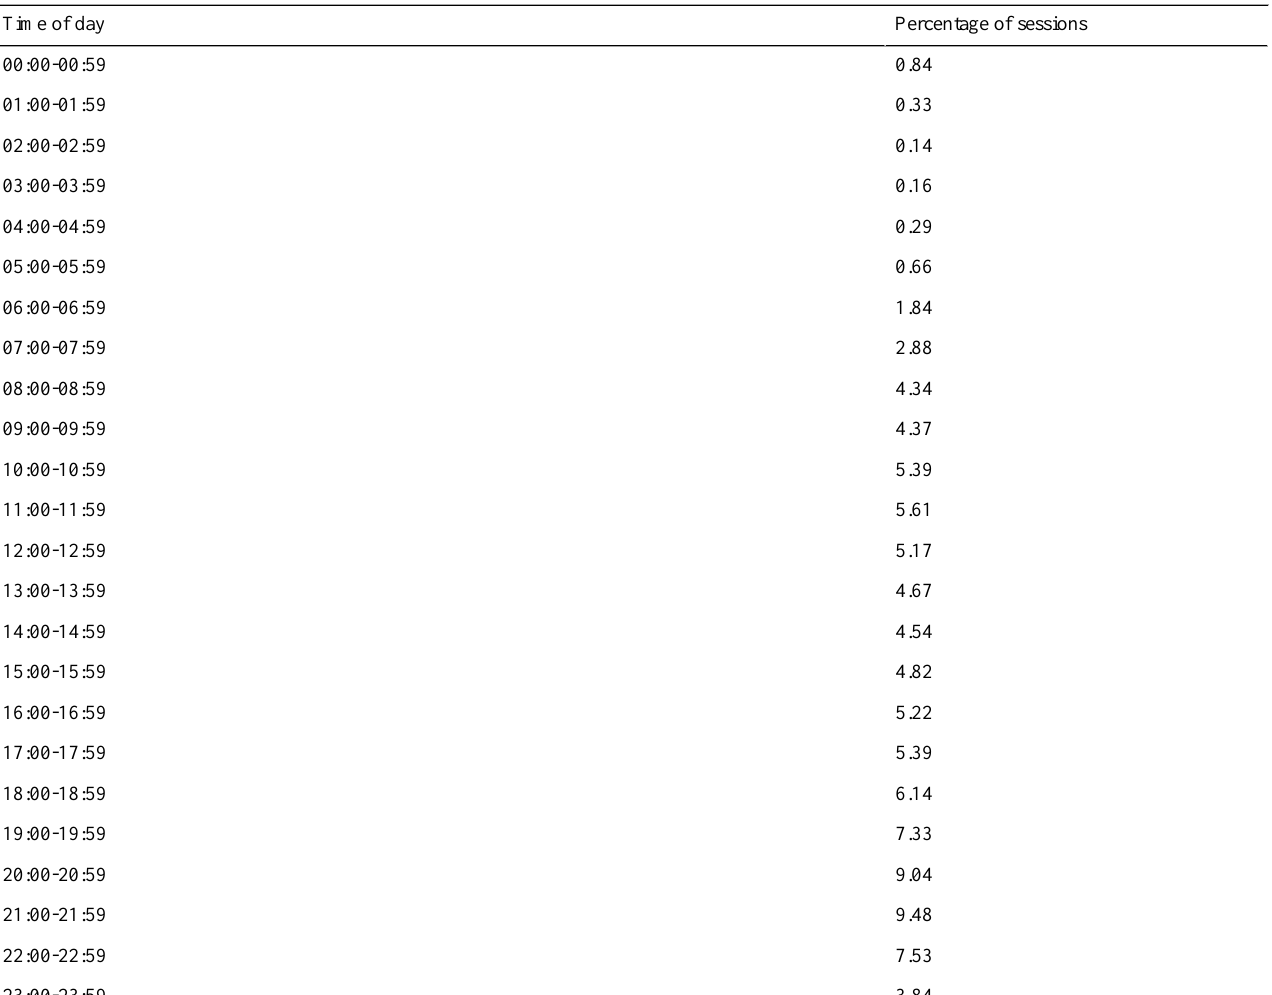
Table 4. Use of the BitHabit app according to the time of